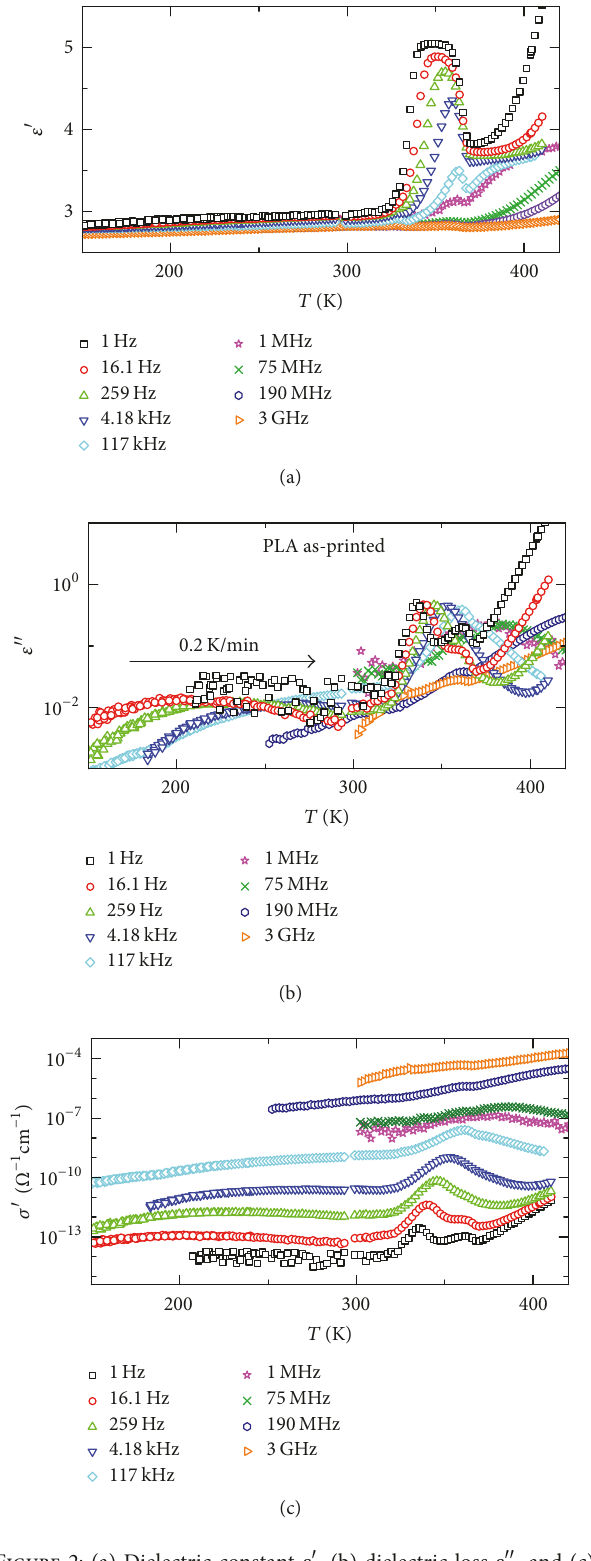
Figure 2: (a) Dielectric constant 𝜀 󸀠 , (b) dielectric loss 𝜀 󸀠󸀠 , and (c) conductivity 𝜎 󸀠 measurements are displayed as functions of temper- ature for PLA in the as-printed condition. Various frequencies in a range of 1Hz to 3 GHz are shown during heating from 150 K to 420 K at a rate of 0.2